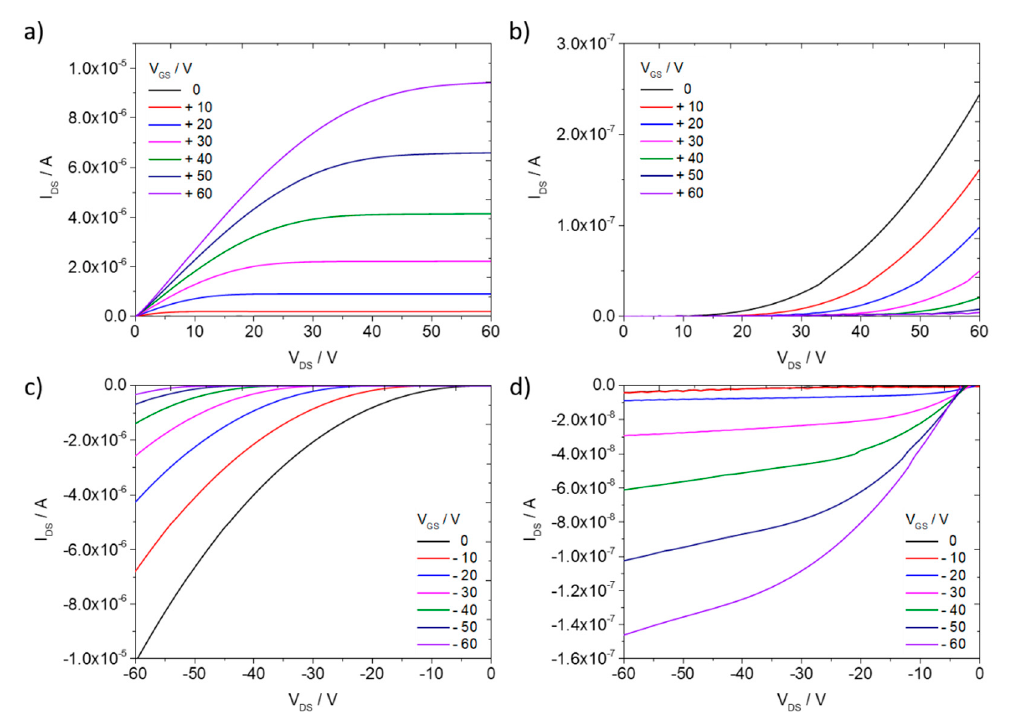
Figure 8. Output characteristics of OFETs based on PBTTT-C 14 :PDI8-CN 2 BHJ film fabricated at 4000 rpm from 100 °C hot solution on OTS modified Si/SiO 2 substrate for ( a , b ) n - and ( c , d ) p-type regimes; ( a , c ) before and ( b , d ) after annealing at 200 °C.